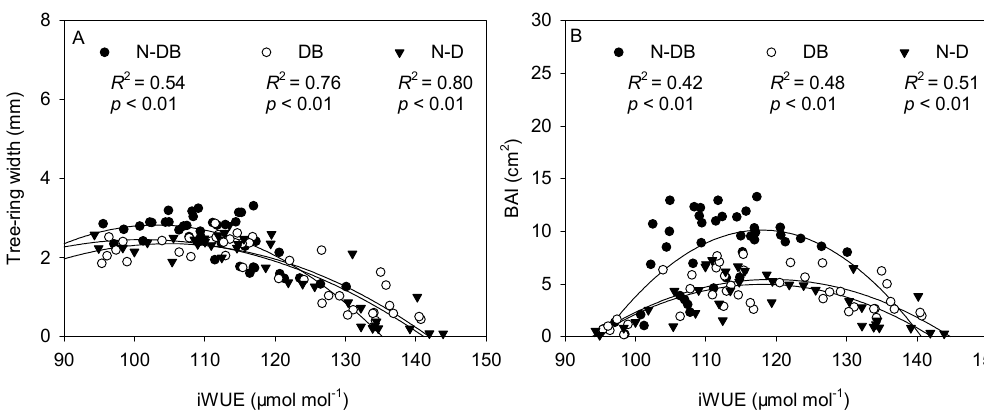
Figure 9. Differences in tree-ring width ( A ) and basal area increments ( B ) in relation to intrinsic water-use efficiency among now-dead (N-D), dieback (DB), and non-dieback (N-DB) poplar tree groups.